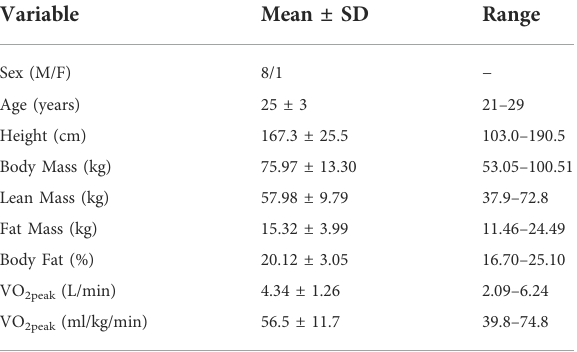
TABLE 1 Selected physiological characteristics of study